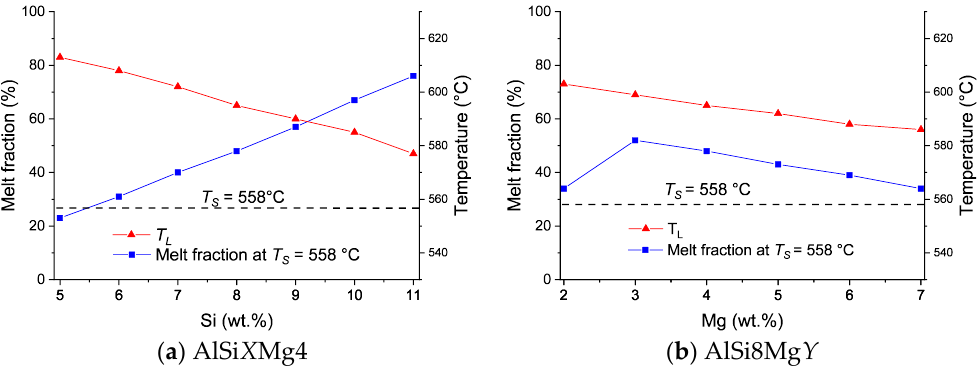
Figure A1. Amount of liquid fraction (in blue) above the solidus temperature Ts = 558 °C calculated with the software Thermo-Calc and the COST507B database for the alloys ( a ) AlSi X Mg4 and ( b ) AlSi8Mg Y for different amounts of Mg and Si, respectively. The corresponding liquidus temperatures T L are marked in red.